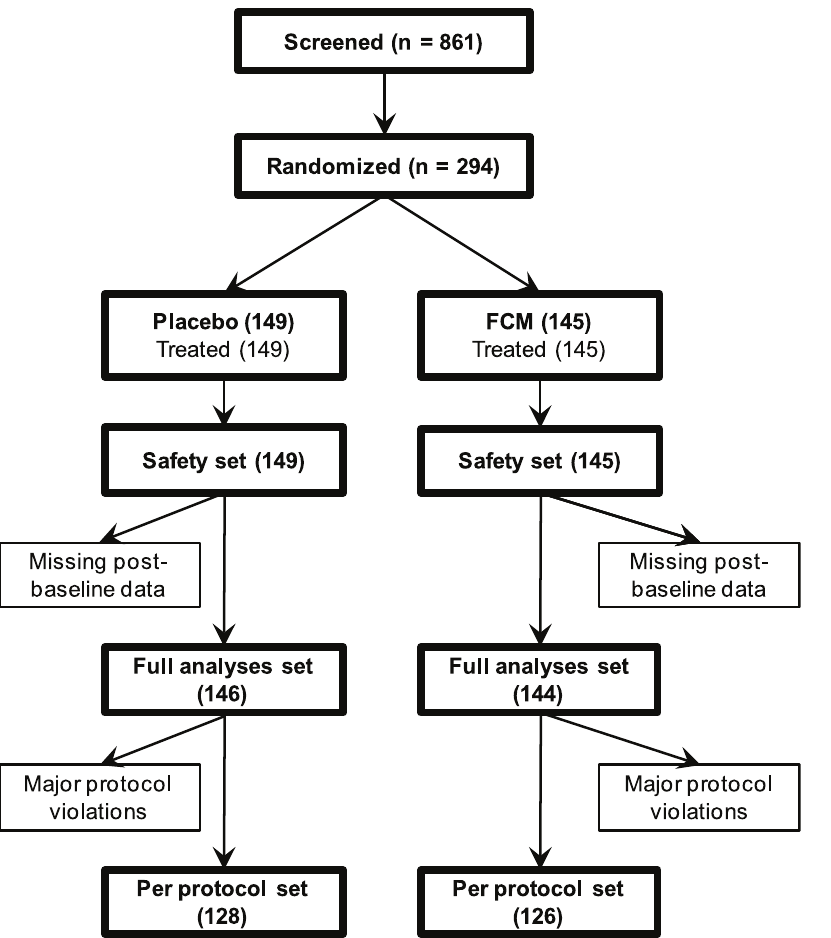
Figure 1. Study flow diagram. The most common major protocol deviations were ‘disallowed concurrent medications’ (15 patients in the placebo and 19 patients in the FCM group) and ‘selection criteria not met’ (5 patients in the placebo and 8 patients in the FCM group).